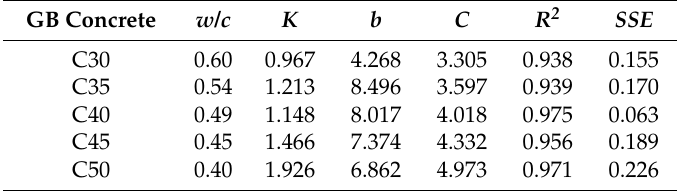
Table 4. First-order Exponential Model: Fitting Coefficients and Goodness of Fit for Equation (4).